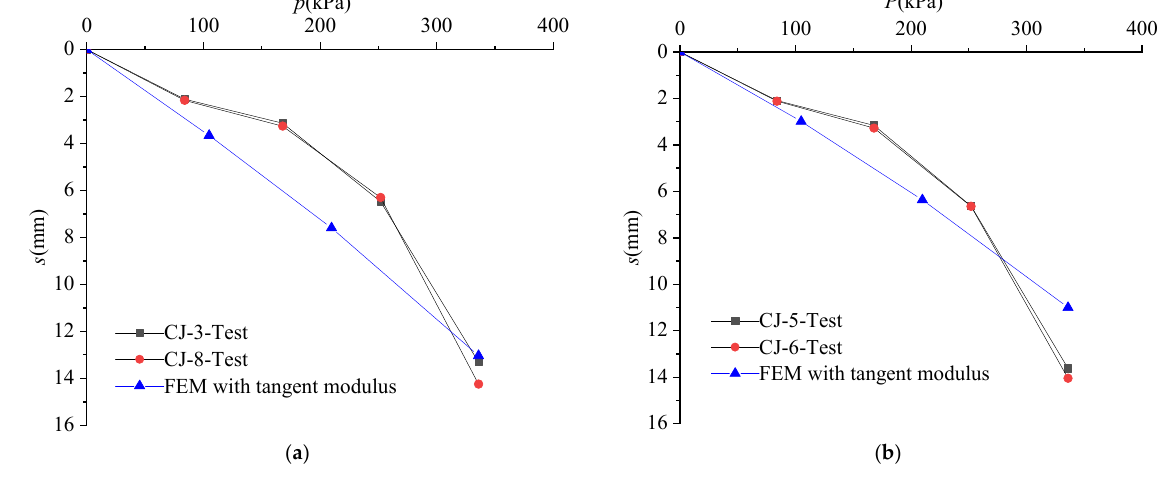
Figure 16. Comparison of finite element and measured p – s curves: ( a ) the midpoint of the boundary line; and ( b ) the corner point.